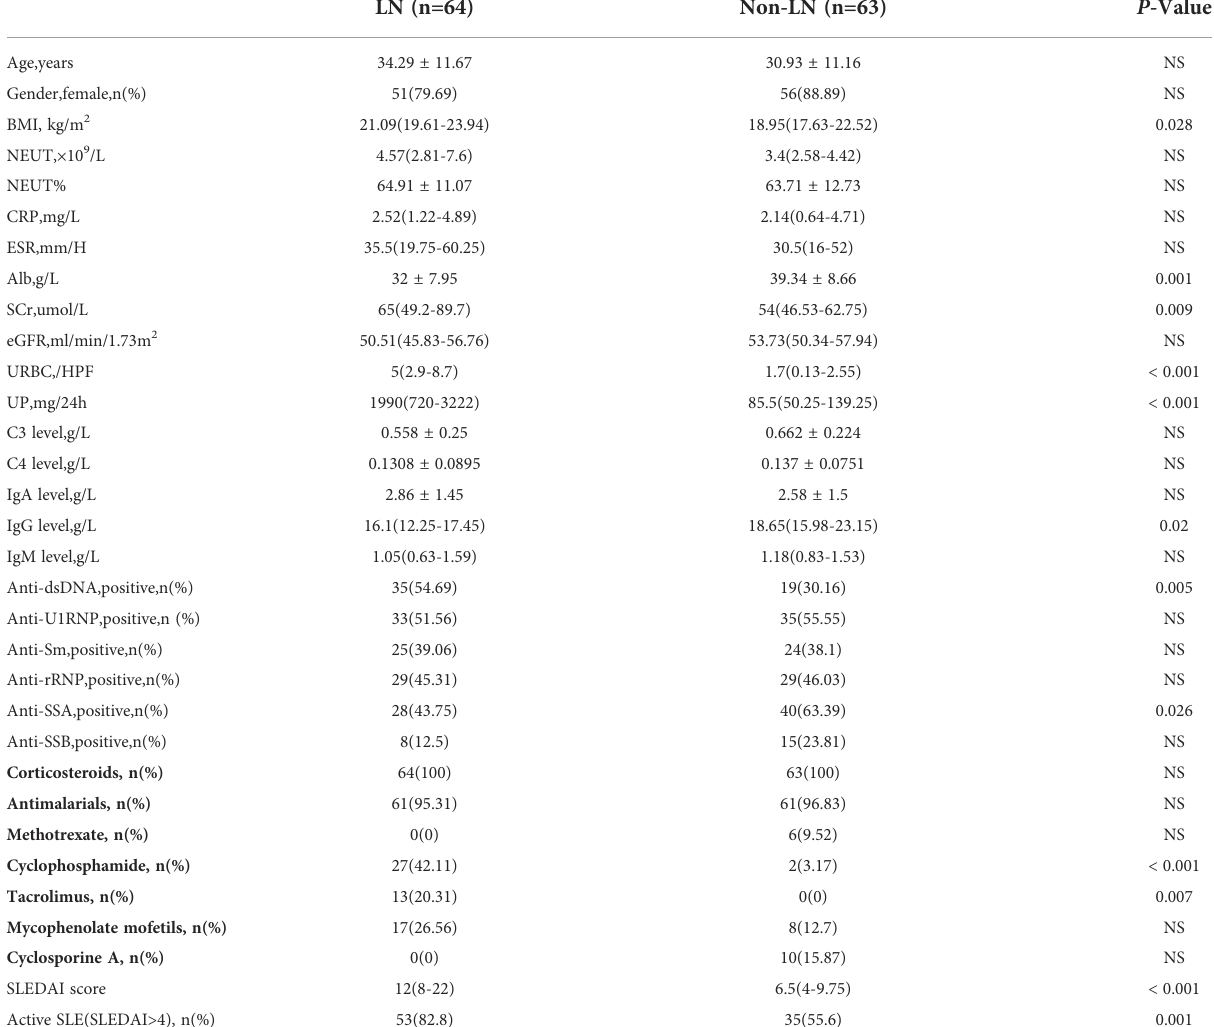
TABLE 1 Patient demographics and clinical